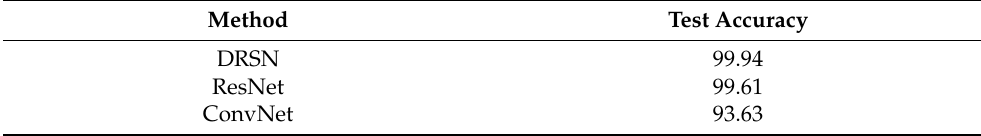
Table 6. Average accuracies of the DRSN, ResNet and ConvNet with Poisson noise